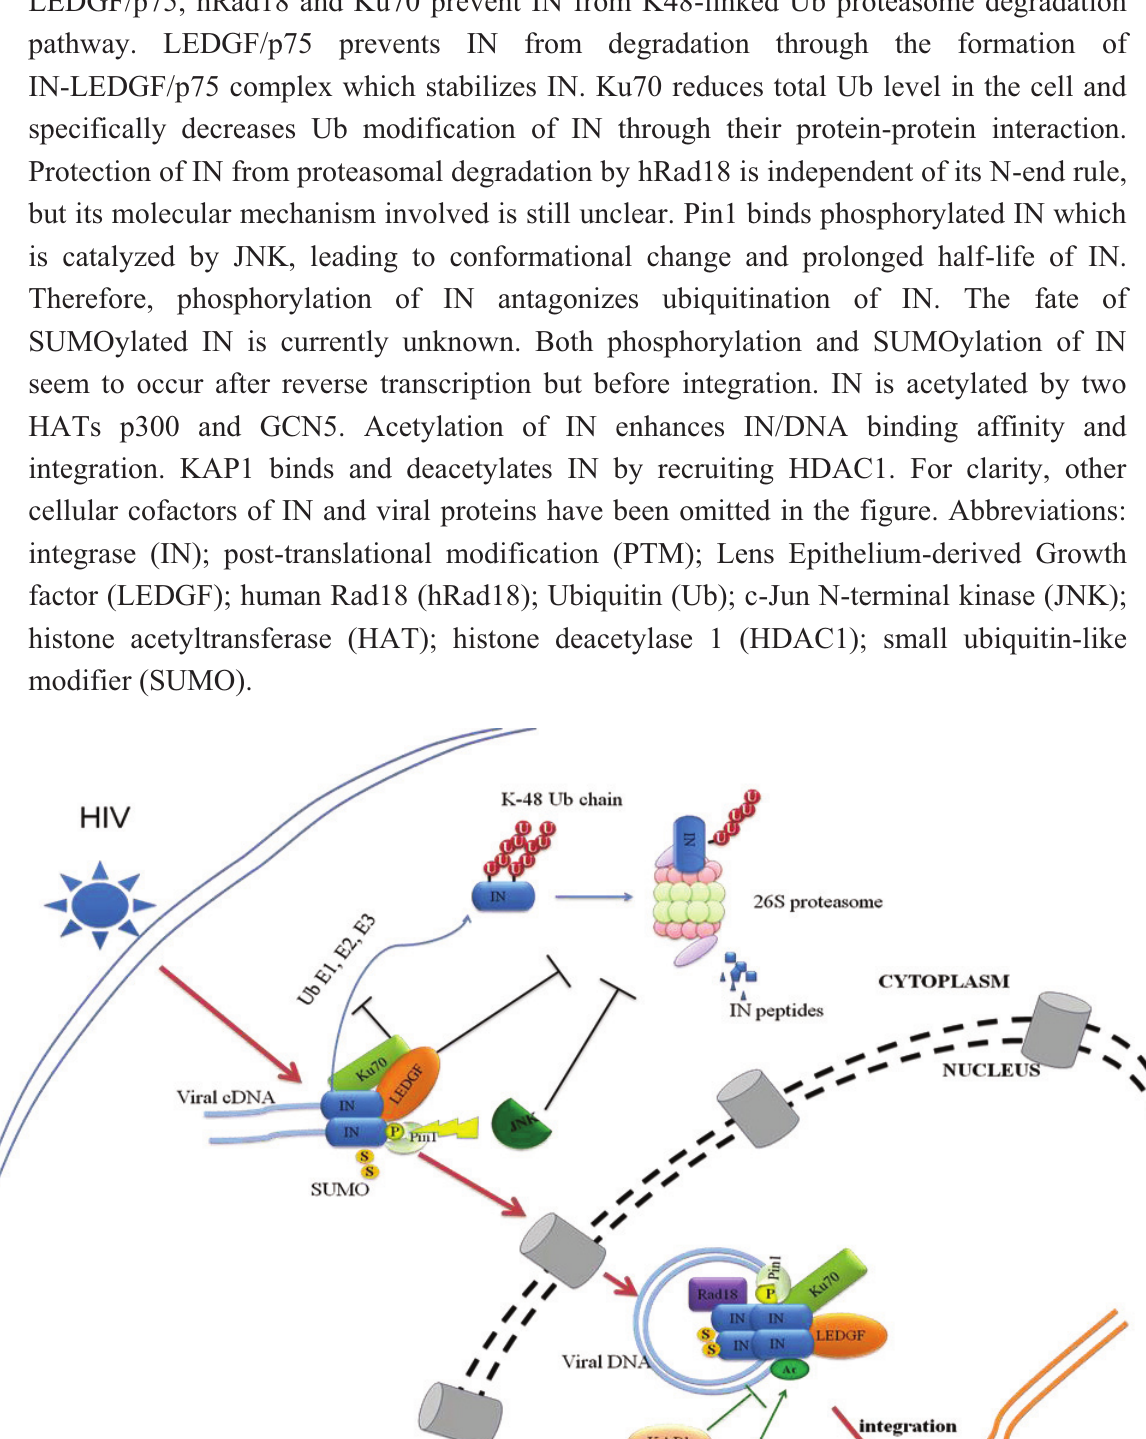
Figure 2. Model for regulation of IN by various PTMs. The interactions of IN with LEDGF/p75, hRad18 and Ku70 prevent IN from K48-linked Ub proteasome degradation pathway. LEDGF/p75 prevents IN from degradation through the formation of IN-LEDGF/p75 complex which stabilizes IN. Ku70 reduces total Ub level in the cell and specifically decreases Ub modification of IN through their protein-protein